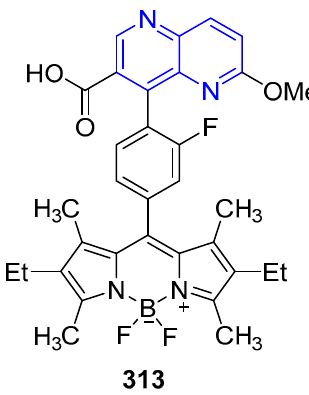
Figure 34. A BODIPY-linked 1,5-naphthyridine-COOH dye.